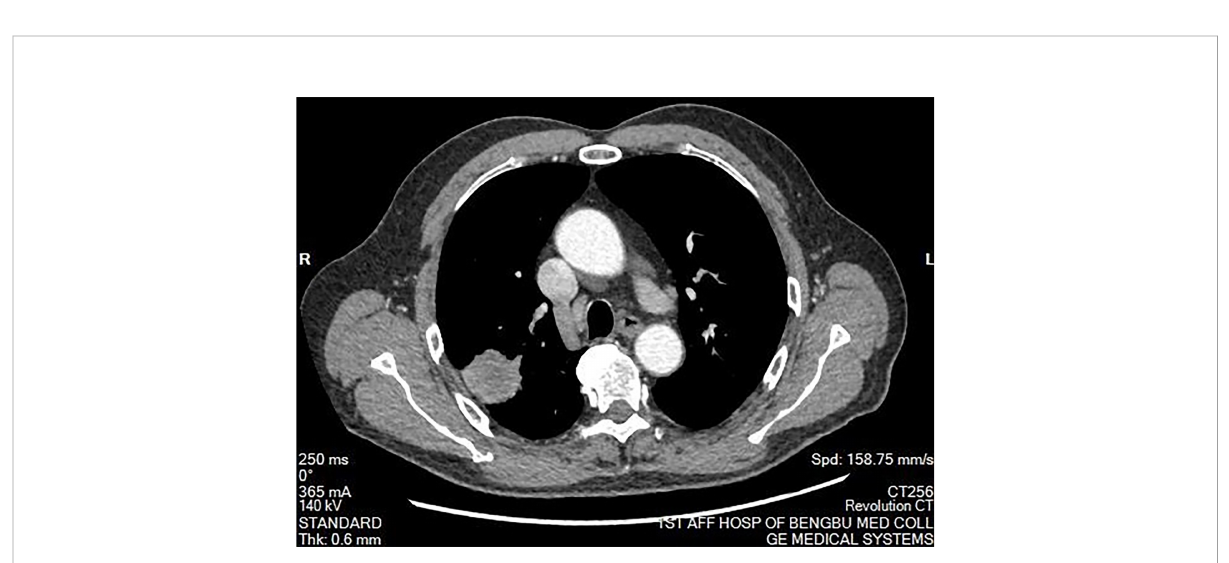
FIGURE 2 Mediastinal window of chest computed tomography. There was no abnormal mass in the mediastinum. The hilum on both sides is normal. There was no pleural effusion on both